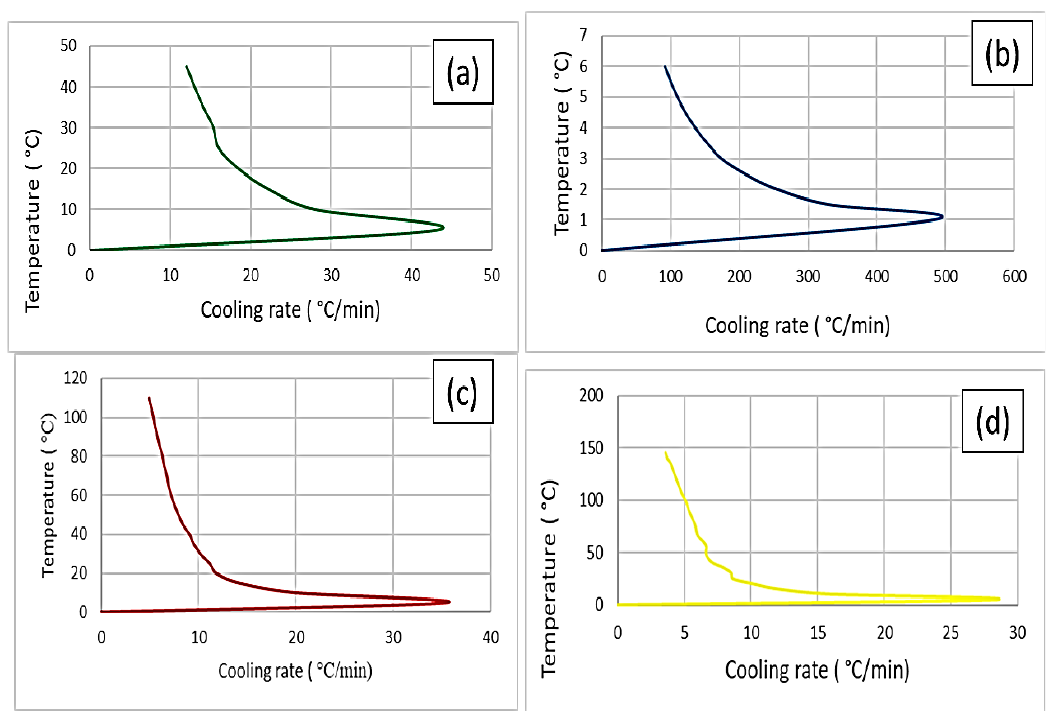
Figure 2: Cooling rate curve of cast specimen (a) cooled in mould at room temperature (b) cooled in mould immersed in ice block (c) cooled in mould at 140 °C (d) cooled in mould at 230 °C.